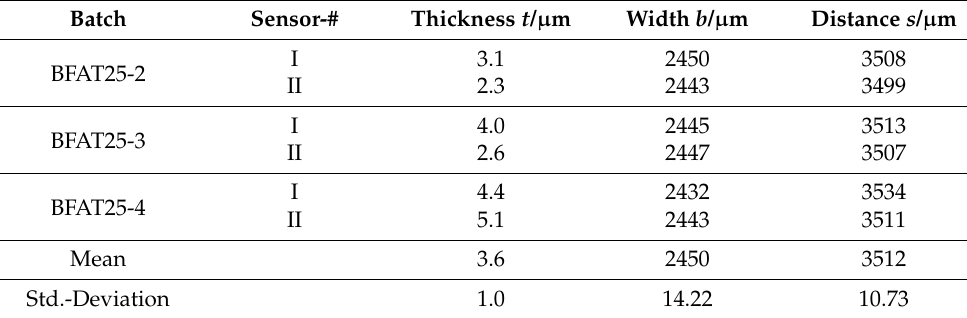
Table 1. Geometric dimensions of the BFAT25